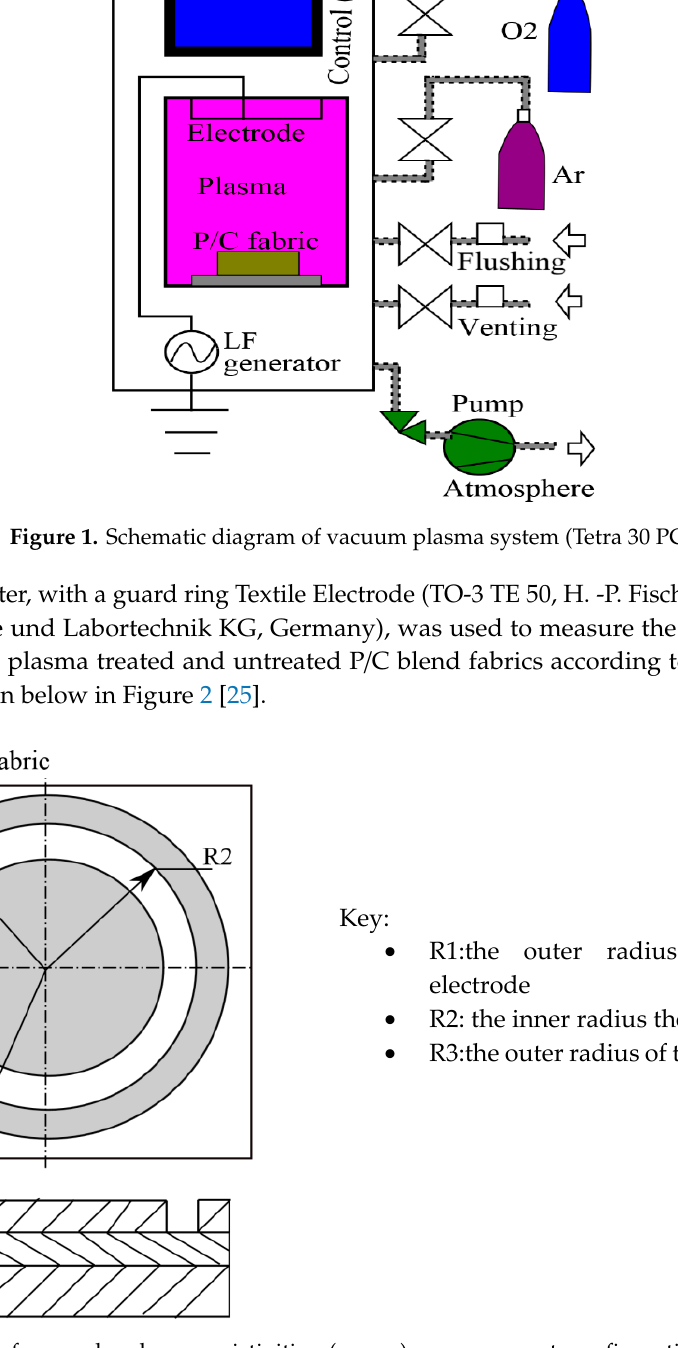
Figure 2. Surface and volume resistivities ( ρ s , ρ v ) measurement configuration of concentric ring electrodes.